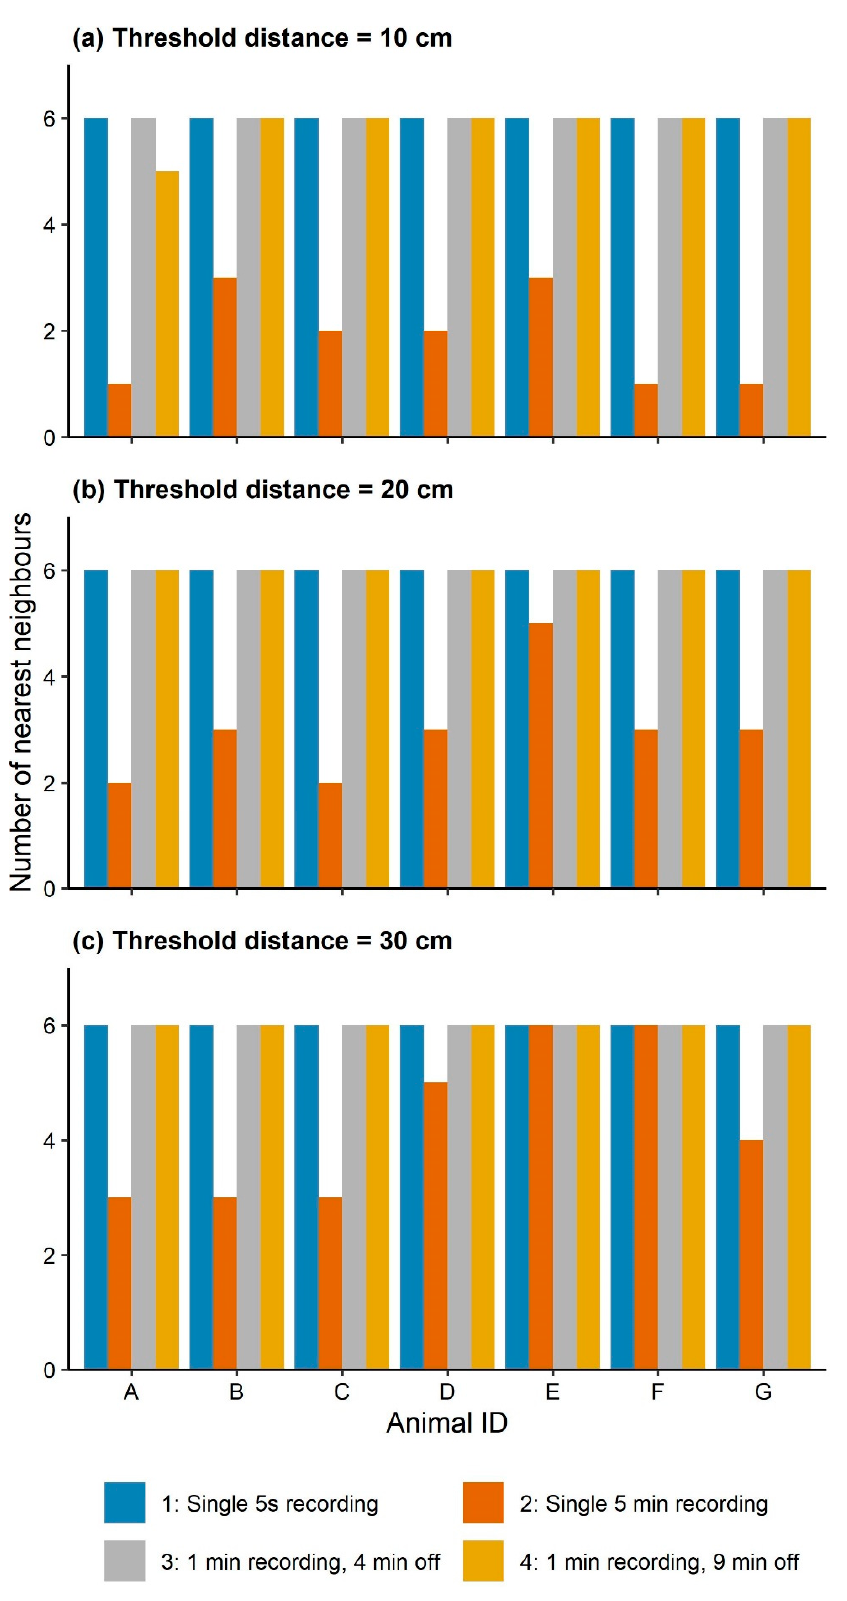
Figure 12. Change in the number of nearest neighbours for individual sheep (A–G) based on different sampling rates (single 5 s, single 5 min, 1 min on (at 1 s) and 4 min off, and 1 min on (at 1 s) and 9 min off) and threshold distances: ( a ) 10 cm, ( b ) 20 cm, and ( c ) 30 cm, during day 2 of the study.